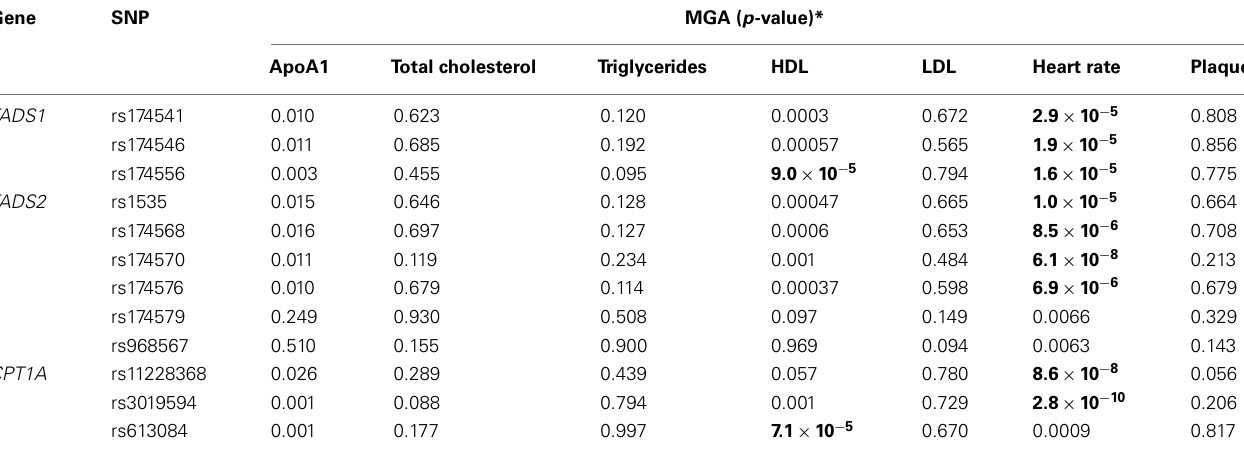
Table 4 | Measured genotype association (MGA) results for SNPs with CVD-related phenotypes. Gene